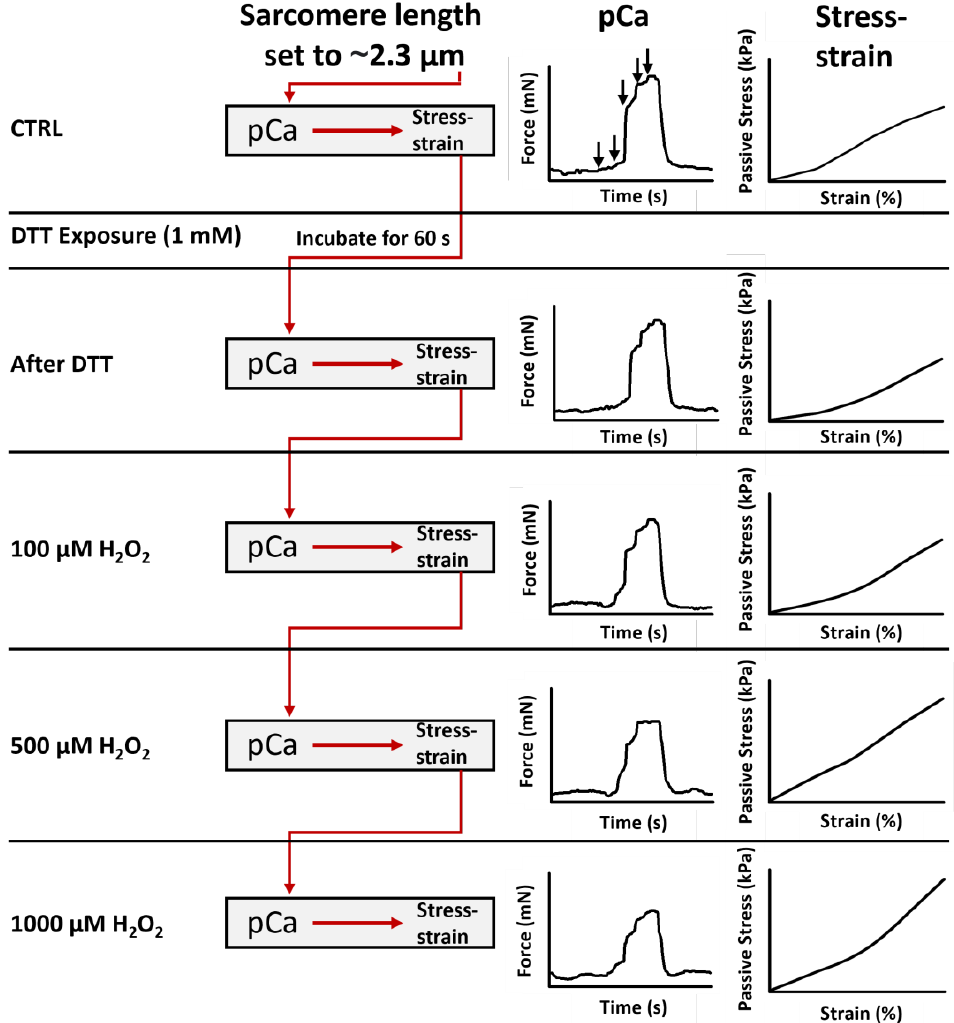
Figure 1. Sequence of recordings performed in one single muscle fibre. Each recording investigated five conditions: Control (CTRL), after 60 s of DTT exposure (1 mM), in 100 µ M H 2 O 2 , in 500 µ M H 2 O 2 and in 1000 µ M H 2 O 2 . For each condition, the single fibre was tested for active force generation in pCa-force curves and passive material properties in stress – strain recordings. While CTRL experiments represent the fibre’s native redox state, a 60 s DTT exposure (1 mM) shifts the redox balance towards a more reduced environment, whereas submersing the fibre in solutions with increasing H 2 O 2 concentration produces a shift towards a more oxidizing environment. The vertical arrows indicate pCa solution exchanges. Axis are equally scaled for each respective recording protocol.